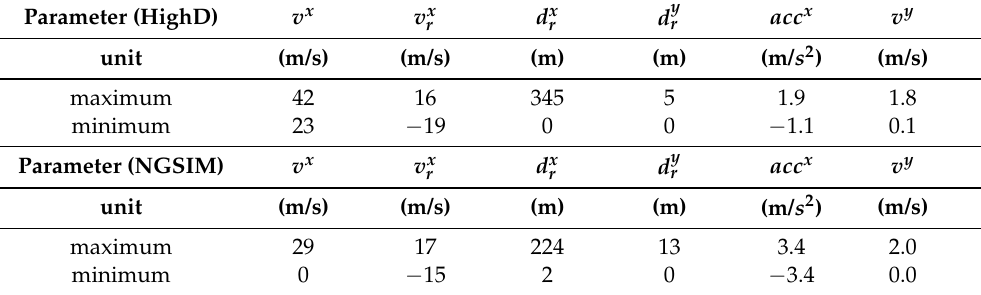
Figure 9. An illustration to show the distribution and density of parameters in the cut-in case based on the HighD and NGSIM. Table 4. Value range of parameters in cut-in